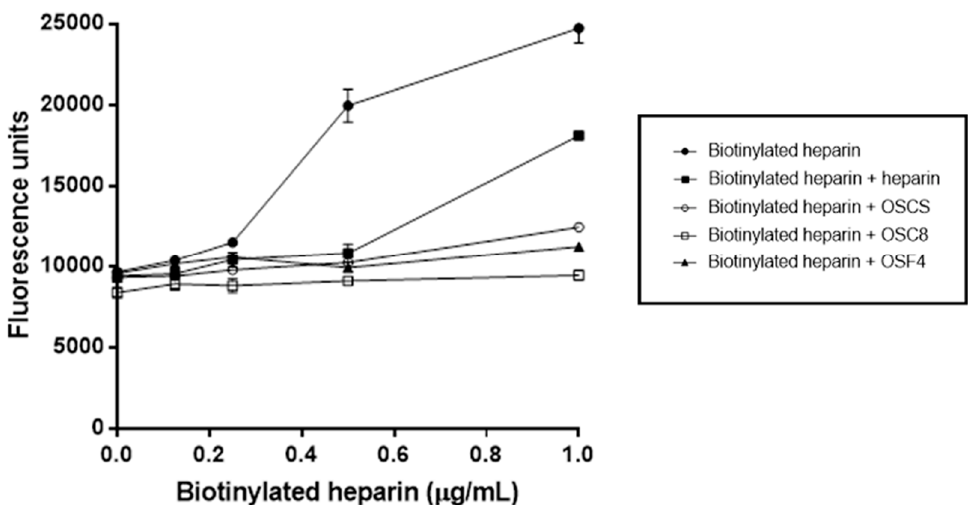
Figure 10. Isolated sulfated contaminants bind to endothelial cells. Endothelial cells were cultured in 96-well plates in F12 medium containing 10% FBS. The cells were exposed to different concentrations of biotinylated heparin plus molar excess of standard heparin or sulfated contaminants. Binding of biotinylated heparin to cells was detected by incubation with Europium-conjugated streptavidin and fluorescence analyzed on a fluorescence reader. Biotinylated heparin binds to EC in a dose dependent manner. This binding is decreased in the presence of excess molar amounts of all the tested contaminants as also observed for standard heparin. Heparin: standard heparin; OSCS: standard oversulfated chondroitin sulfate; OSC8: sulfated contaminant purified isolated from crude heparin preparation C8; OSF8: sulfated contaminant purified from final heparin product F8.